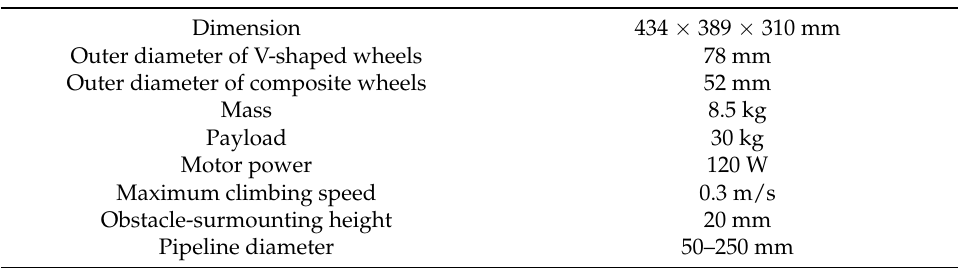
Table 1. Parameters of the pipeline-climbing